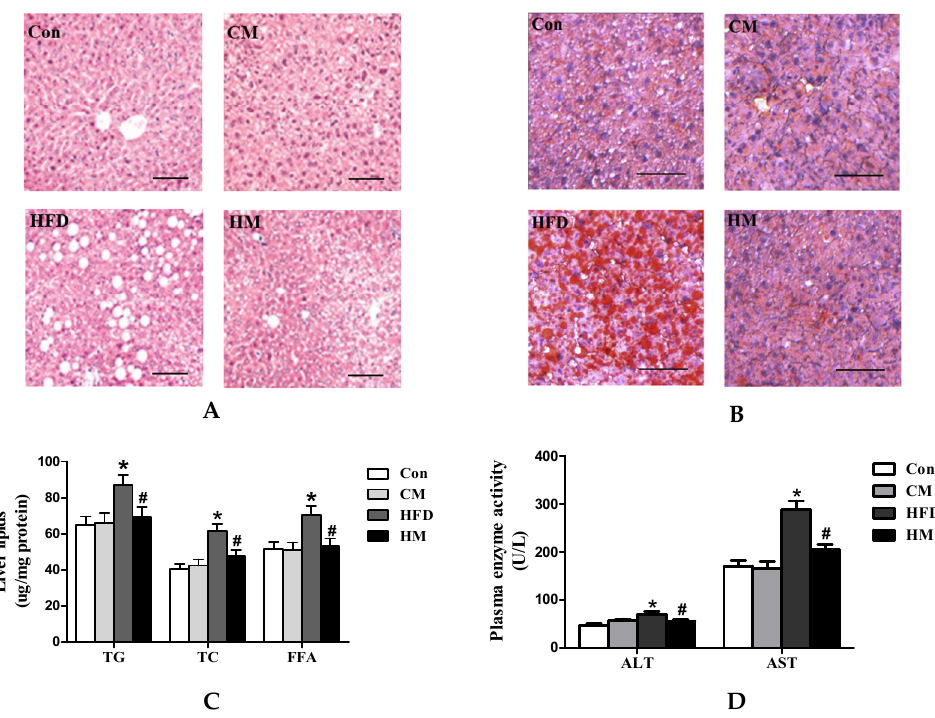
Figure 3. Myricetin reduced hepatic lipid accumulation and increased liver function of mice fed with a high ‐ fat diet. ( A ) Representative images of liver H & E staining ( n = 4); ( B ) representative images of liver Oil Red O staining ( n = 4); ( C ) hepatic TG, TC, FFA levels ( n = 8); ( D ) plasma ALT and AST activities ( n = 8). Values were presented as mean ± SEM. Scale bars indicate 50 μ m. Con, control diet; CM, control diet with additional 0.12% myricetin; HFD, high ‐ fat diet; HM, high ‐ fat diet with additional 0.12% myricetin. * p < 0.05 vs. the Con group; # p < 0.05 vs. the HFD group.